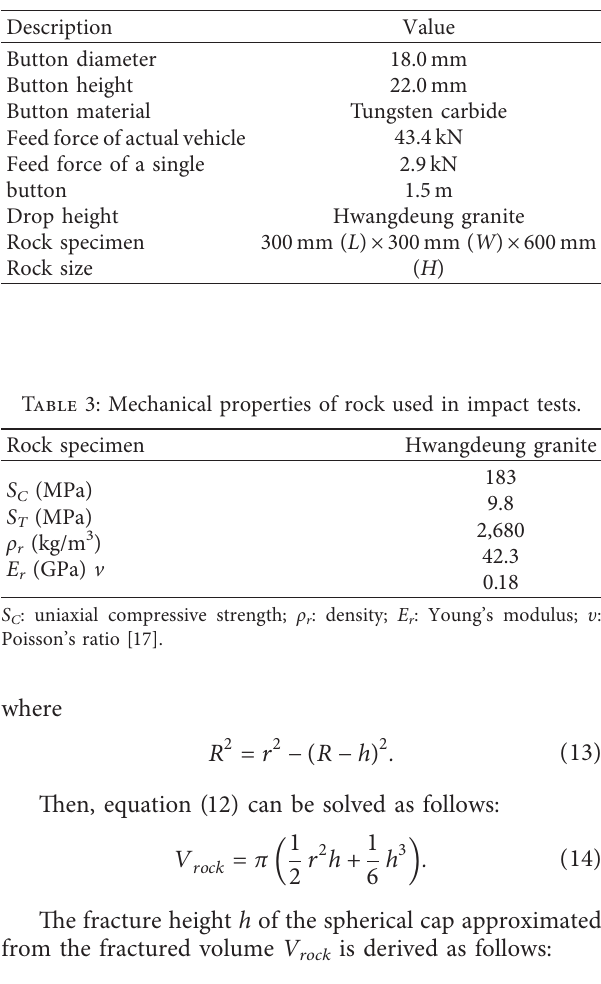
Figure 6: Schematic of the button impact testing system: (a) cross-section and (b) picture. Table 2: Parameters of the button impact tests.